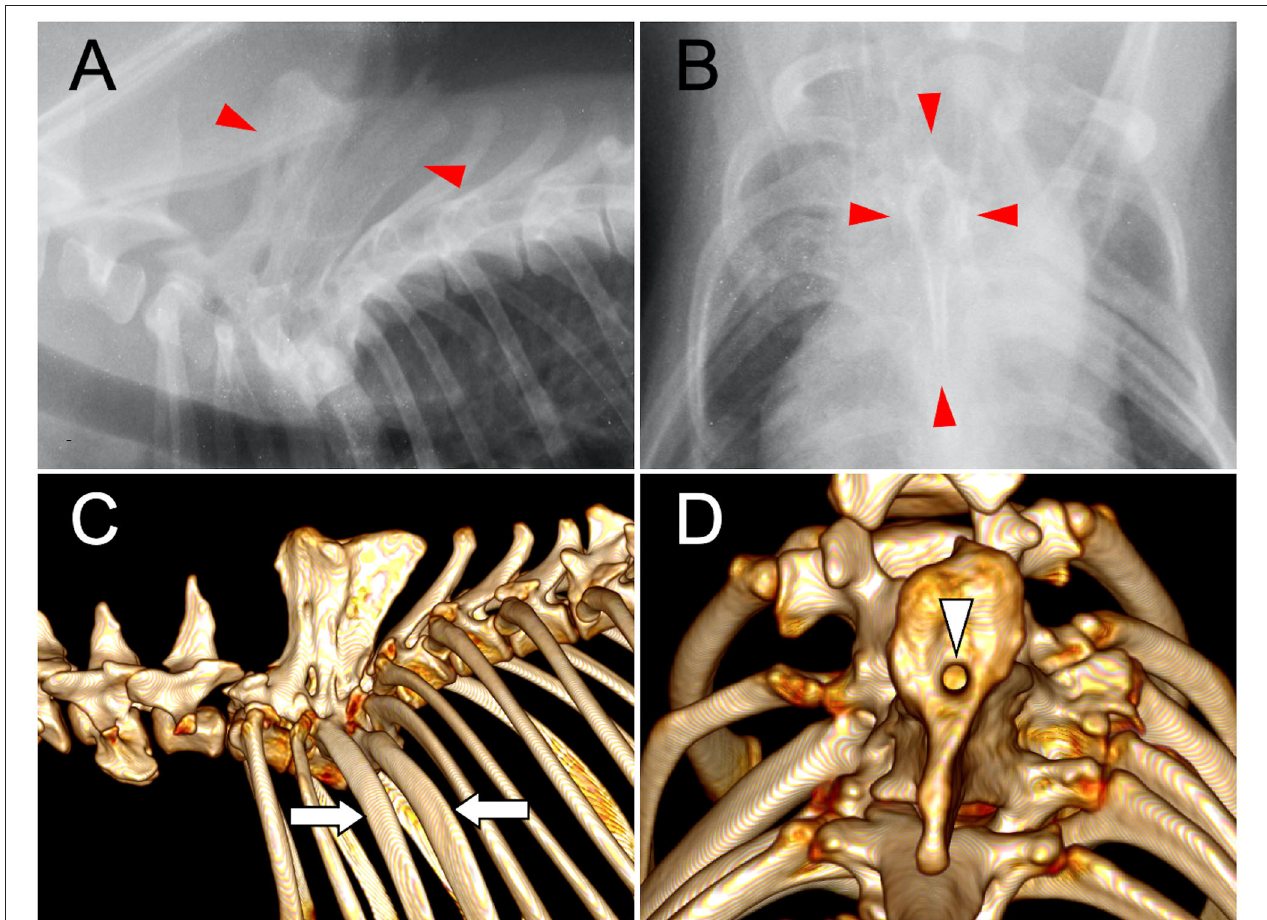
FIGURE 1 | Plain radiographs and CT images of the thoracic spine at the referral hospital. Right lateral (A) and ventrodorsal (B) radiographs showed severe lordosis and conjoined spinous process of T1–T5 (arrowheads). Reconstructed three-dimensional CT images of the thoracic vertebrae (C,D) . The spinous processes of T1–T5 were fused and the ribs of T3 and T4 were abnormally thickened (arrows) (C) . On the dorsal view, the tubular opening (arrow heads) of the conjoined spinous process is seen (D)